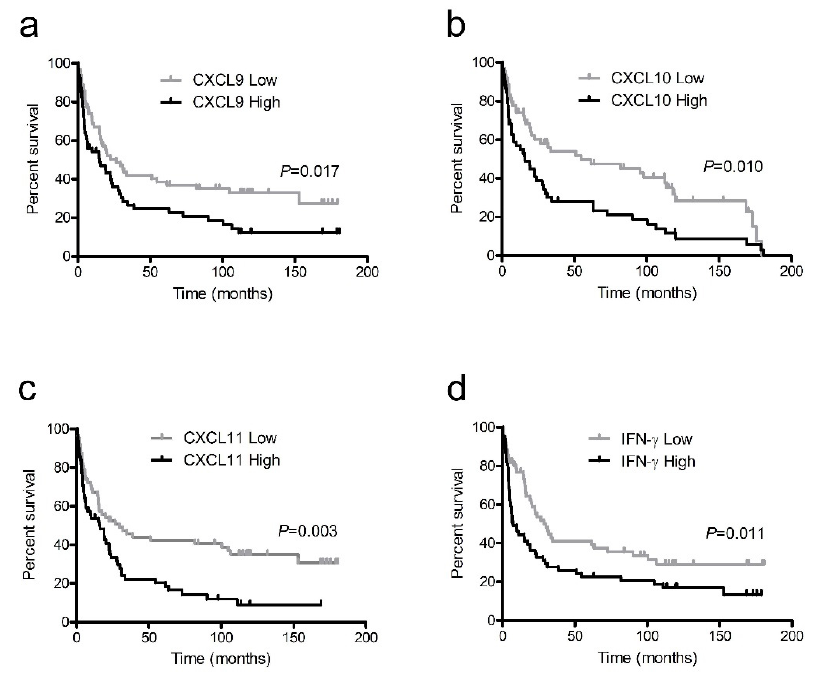
Figure 4. Kaplan–Meier survival curves for cancer-specific survival in non-small cell lung cancer patients with high and low levels of interferon (IFN)- γ -inducible chemokines CXCL9 ( a ), CXCL10 ( b ), and CXCL11 ( c ) and IFN- γ ( d ). Based on the multivariate Cox proportional hazards model, levels of CXCL9 and CXCL11 remained independent prognosticators for overall survival after controlling for significant covariates such as patient age and cancer stage from the univariate Cox model. For the multivariate Cox model for cancer-specific survival, CXCL9 showed significant results and CXCL11 showed a trend toward significance as independent prognosticators after controlling for the same covariates. CXCL10 and IFN- γ failed to show significant results in the multivariate survival analysis (Table 3). Table 3. Univariate and multivariate Cox proportional hazards model for overall and cancer-specific survival in patients with non-small cell lung cancer.